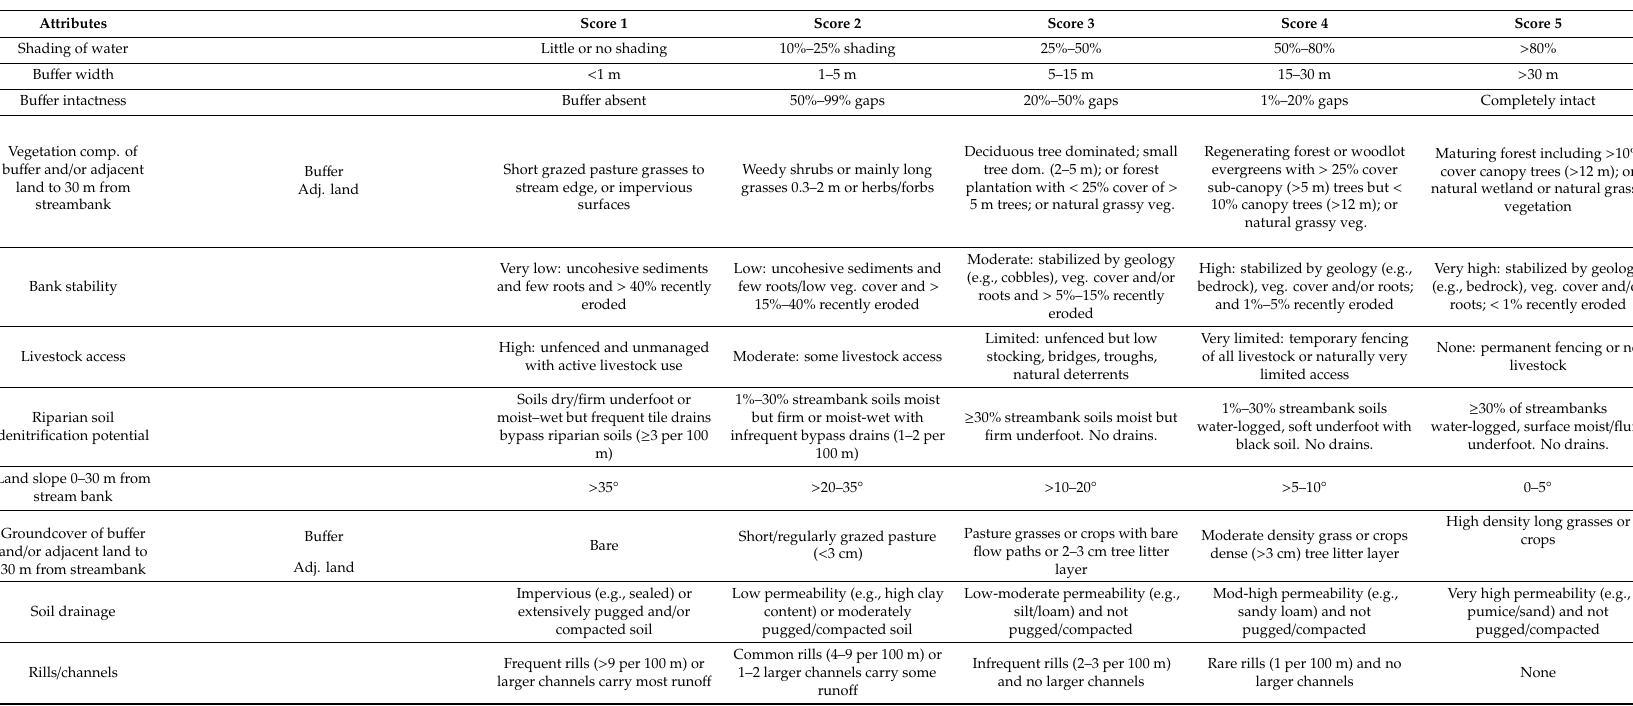
Table 3. Scores for riparian attributes used to calculate the Riparian Condition Index (RCI) (adapted for European conditions from Harding et al. [36]).